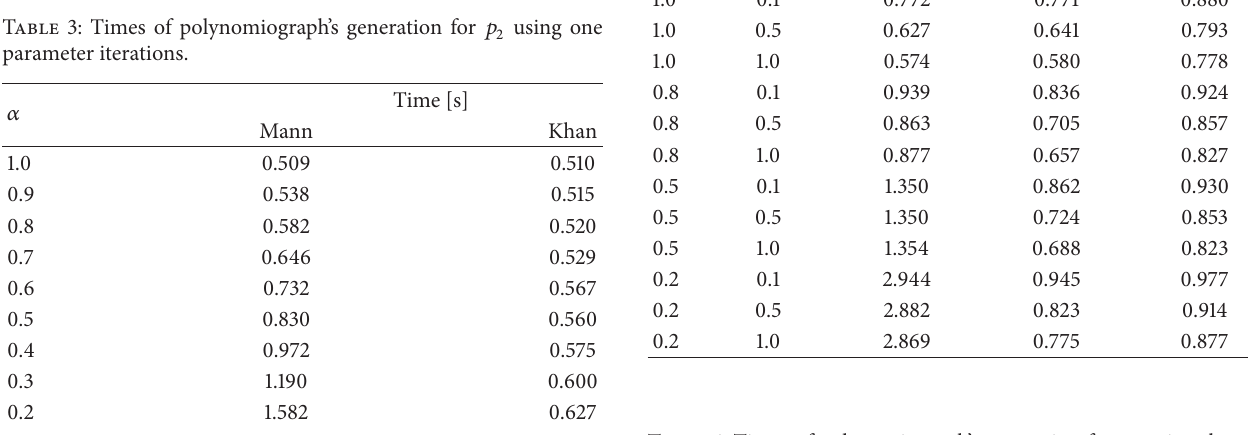
Table 6: Times of polynomiograph’s generation for 𝑝 1 using three parameters